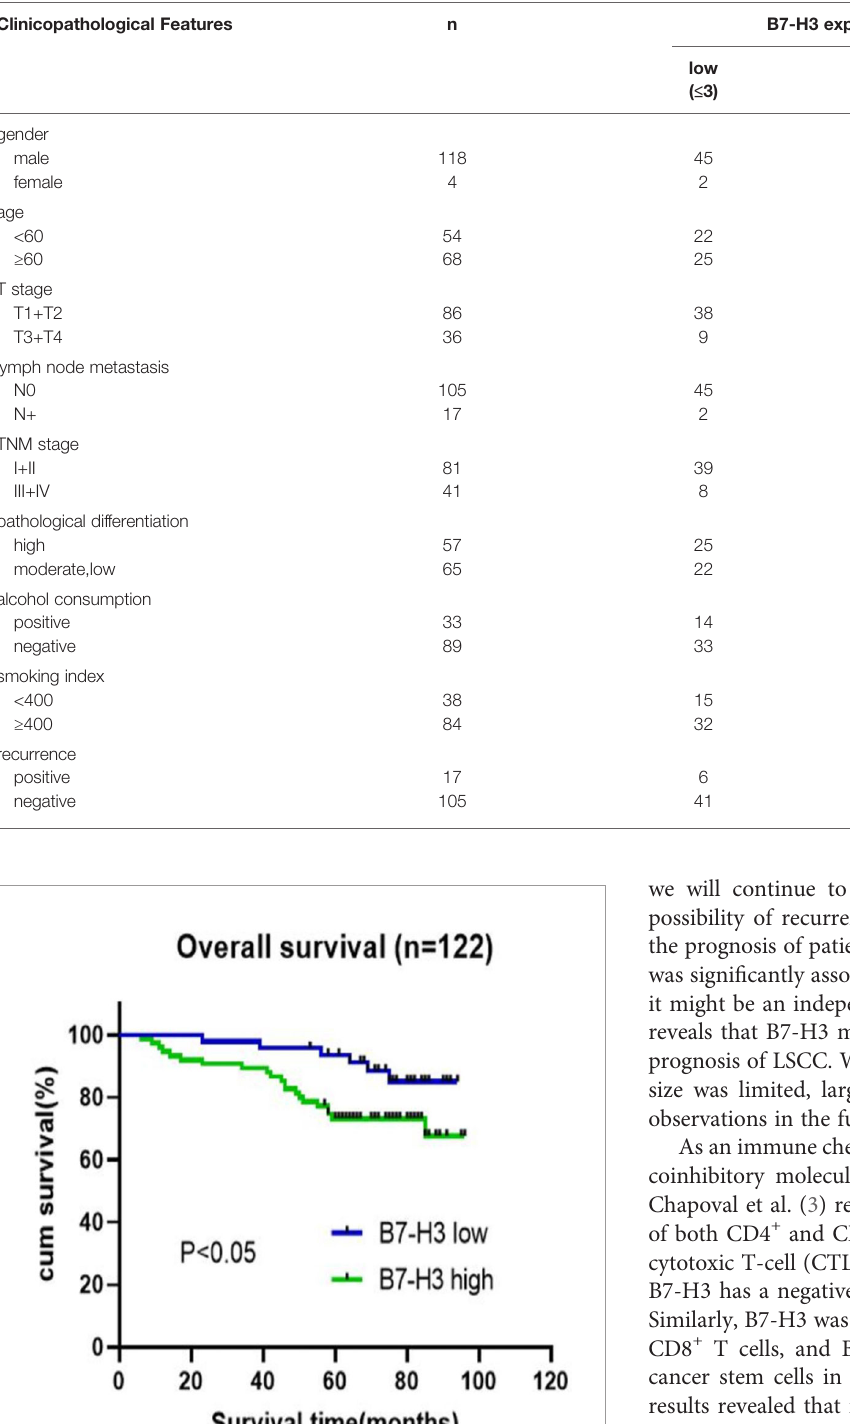
TABLE 1 | Clinicopathological factors associated with B7-H3 expression levels.